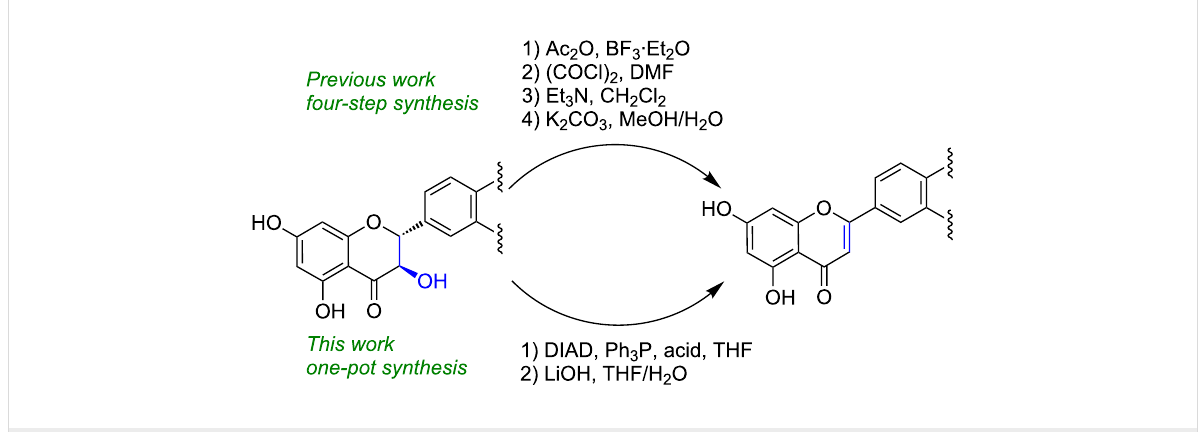
Figure 2: Synthetic strategy of semi-synthesis of hydnocarpins from silybins [22].